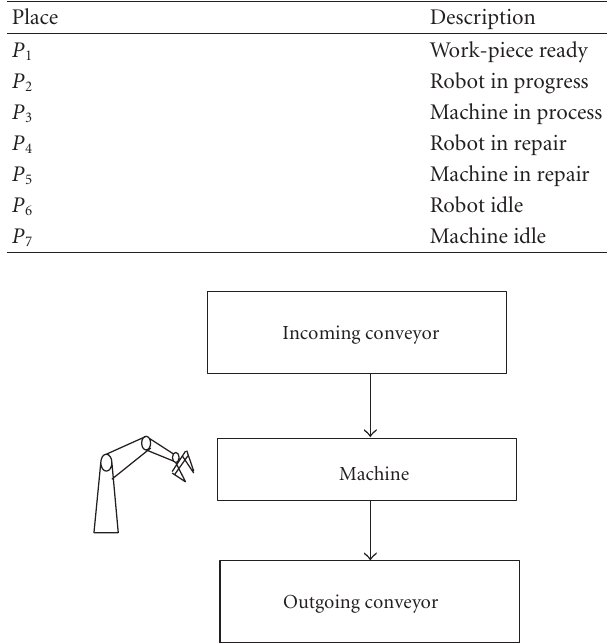
Figure 6: A flexible manufacturing cell.